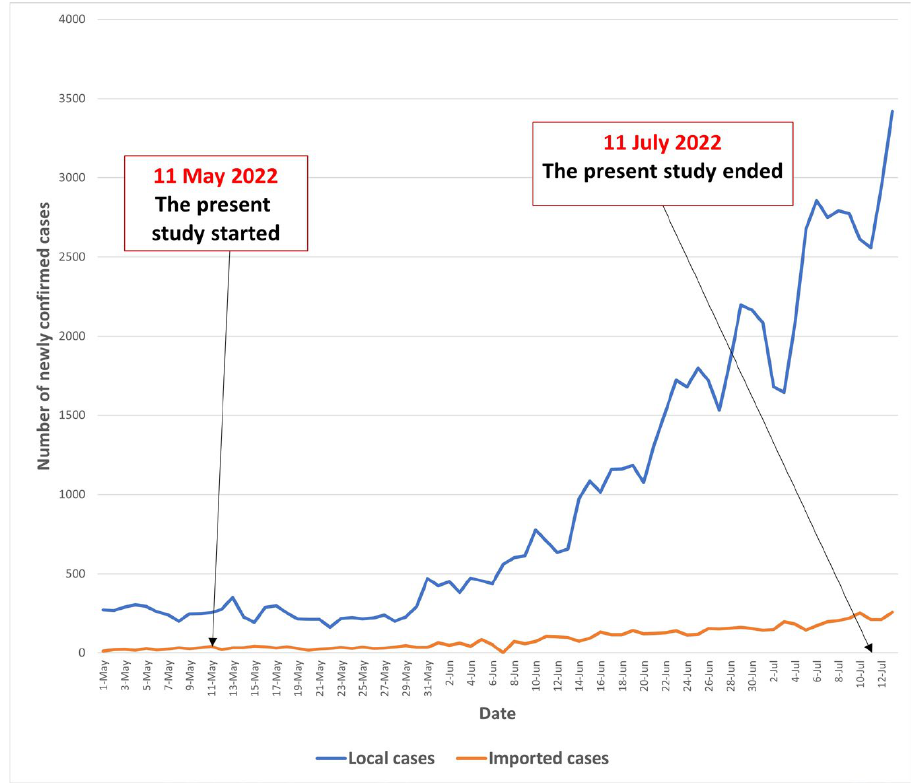
Figure 1. The COVID-19 situation in Hong Kong during the study